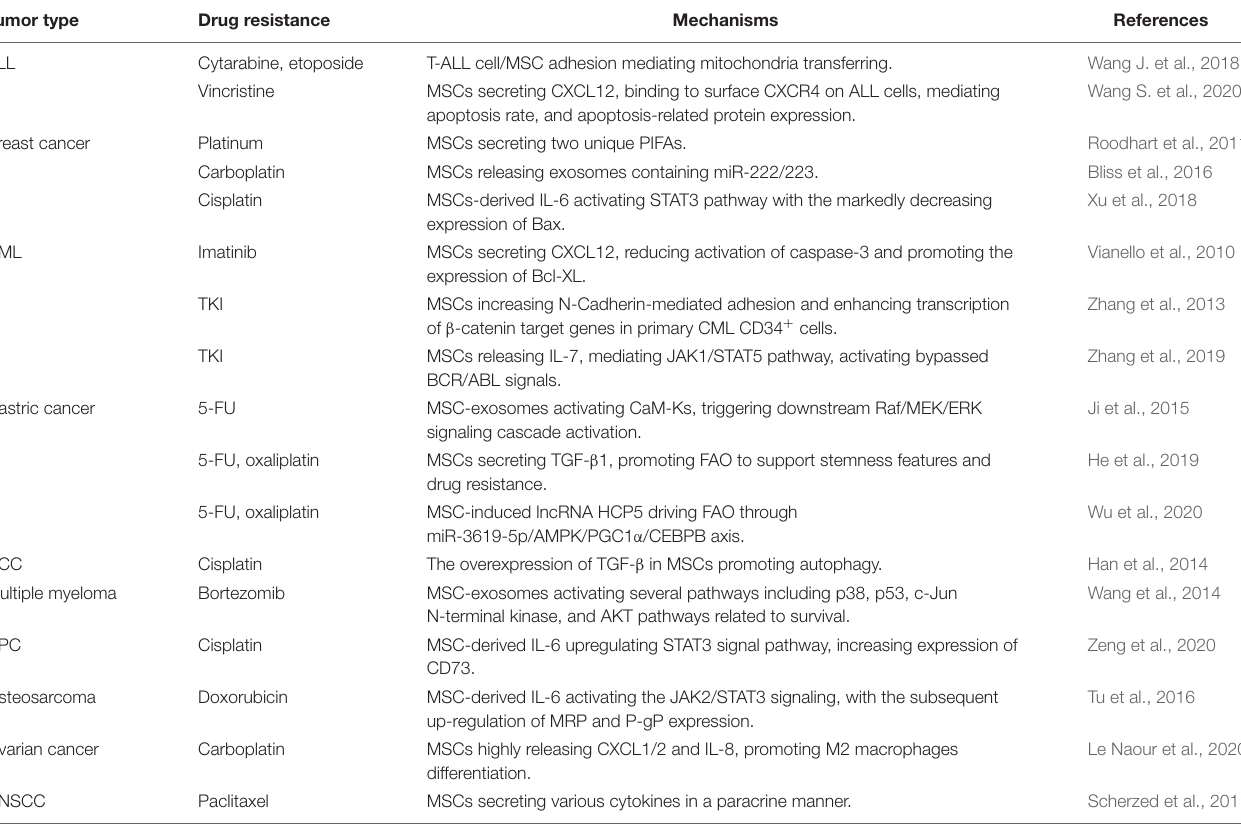
TABLE 5 | Mechanisms of antitumor drug resistance mediated by